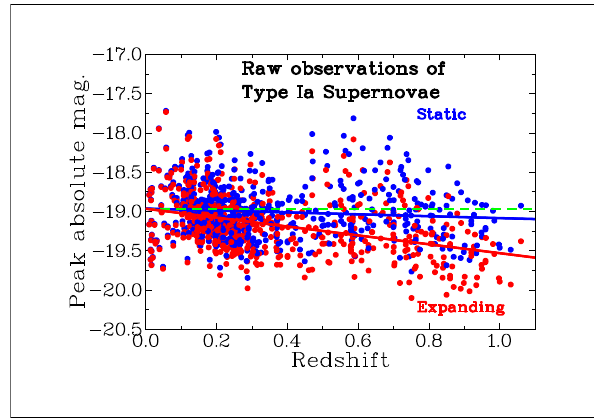
Figure 3. Plot of the measured absolute magnitude for each super- nova as a function of redshift both static (blue points) and expand- ing (red points) cosmologies. The blue line shows the regression line given as the first line in Table 3 and the red line shows the ex- pected absolute magnitude if there was an expanding universe (second line in Table